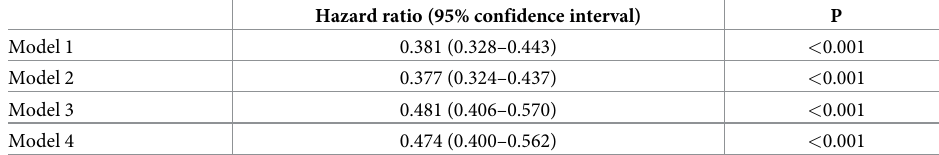
Table 3. Hazard ratio of all-cause mortality in patients with consultation compared with those without consultation.